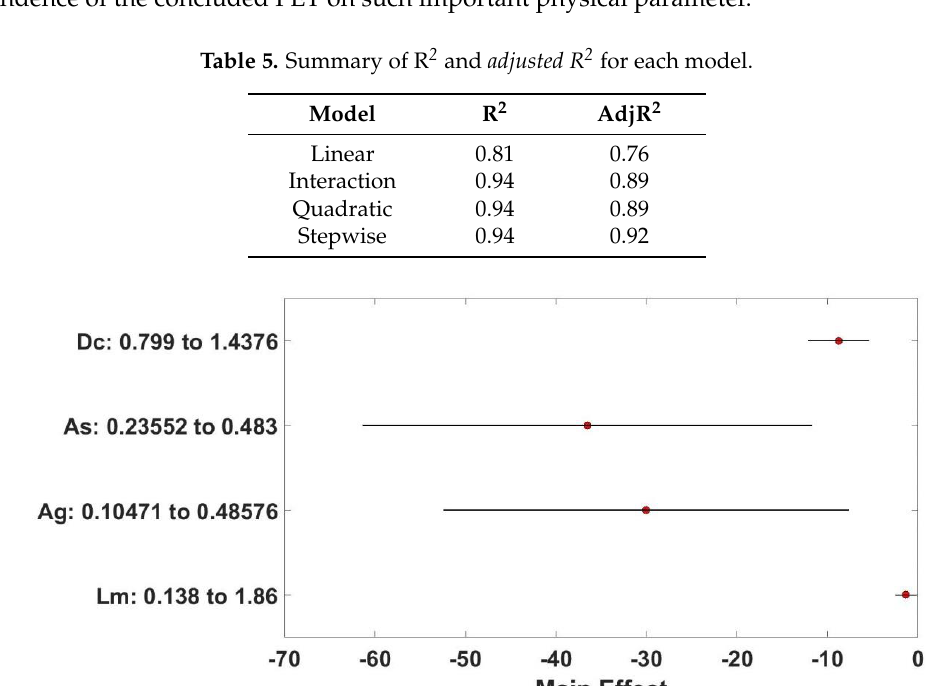
Figure 13. Main effects of design variables.